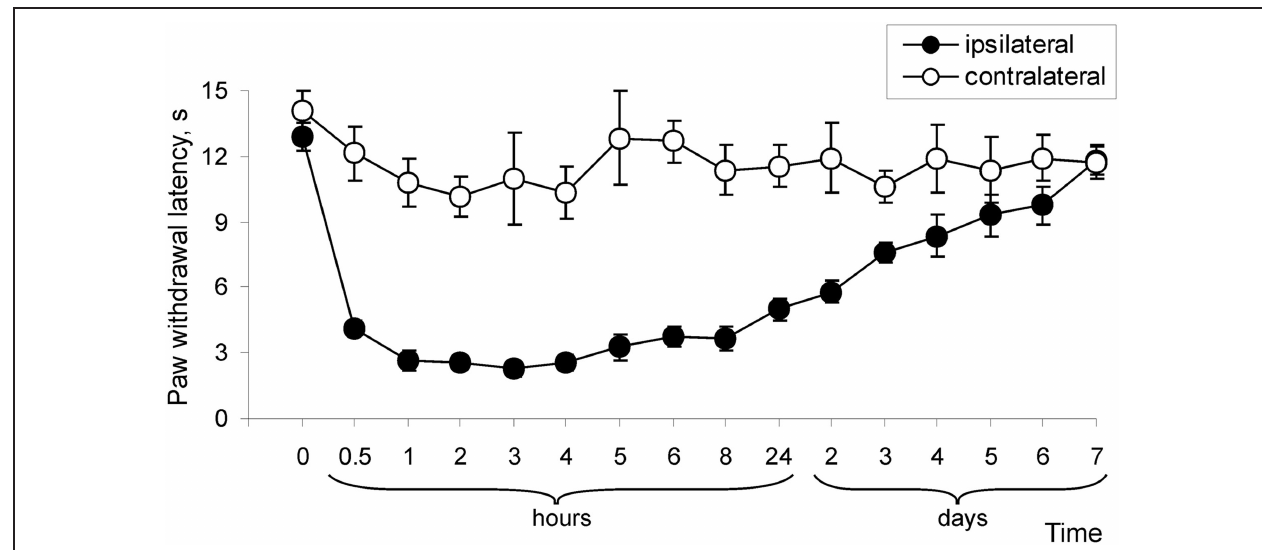
FIGURE 1 | Development of CFA-induced peripheral thermal hypersensitivity in rats. CFA injection induced a decrease in paw withdrawal latency in response to thermal stimulation ( n = 6/time point).